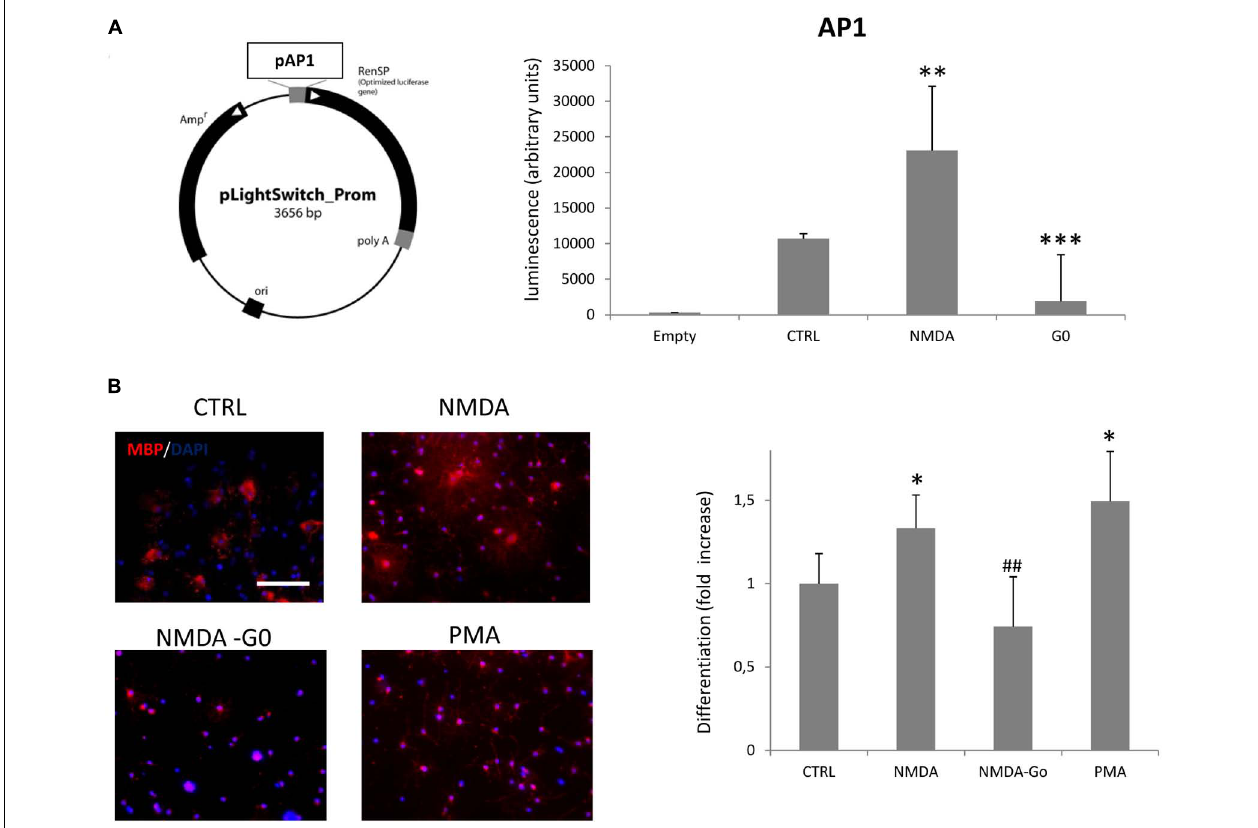
FIGURE 1 |Activation of NMDA receptors in neurospheres induces PKC activation and oligodendrocyte differentiation.(A) Pre-differentiated neurospheres were dissociated and transfected with 3 μ g of pAP1- LightSwitch. Cells were differentiated for 12 h in the presence of 100 μ M NMDA or 100 nM G0 6893. Empty vector, without AP1 promoter, was transfected as a negative control. (B) Neurospheres were differentiated to oligodendrocyte for 3–5 days in the presence of 100 μ M NMDA, 100 nM